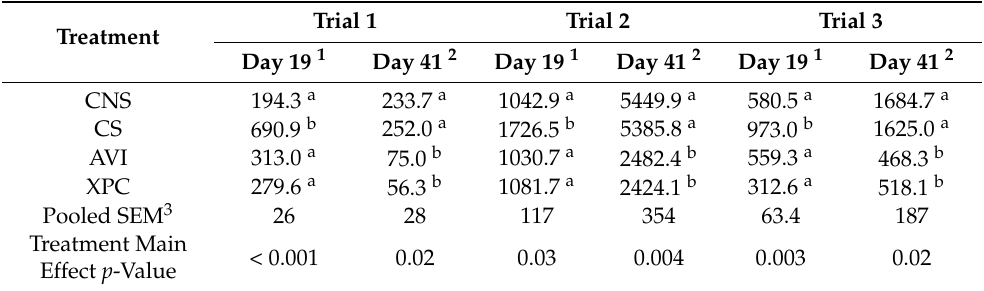
Table 1. Plasma corticosterone (pg/mL) after an acute stress challenge (day 19) and after 41 days of